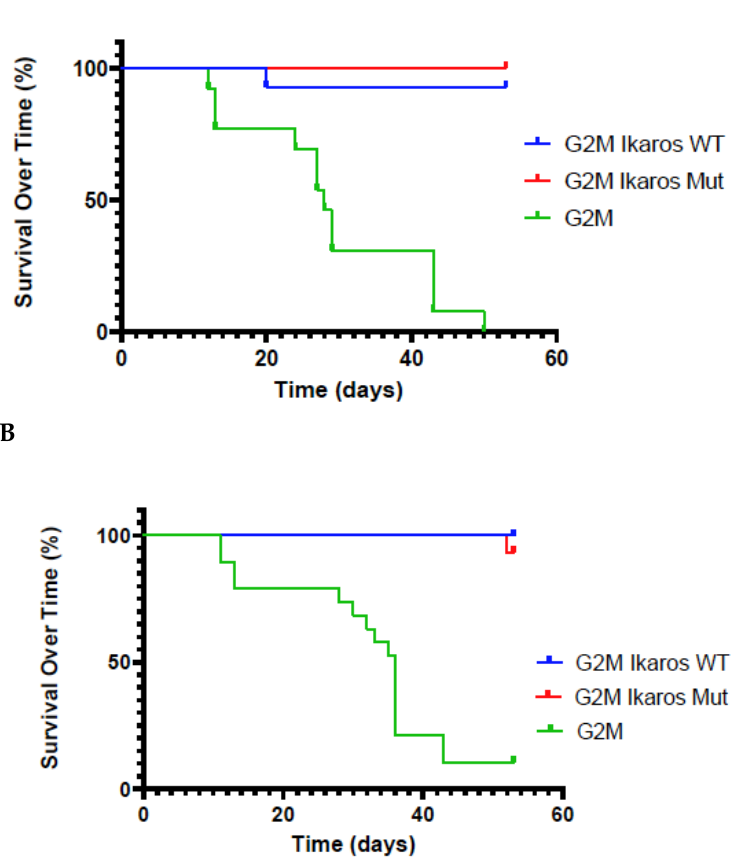
Figure 3. Survival curves of chickens in replicates across experimental groups. Chick mortalities that occurred prior to 10 days of age were excluded from analysis in both Replicate 1 ( A ) and Replicate 2 ( B